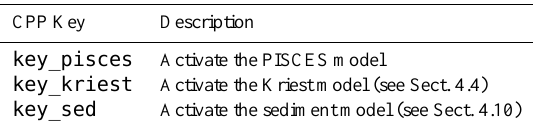
Table 3. Available CPP keys in